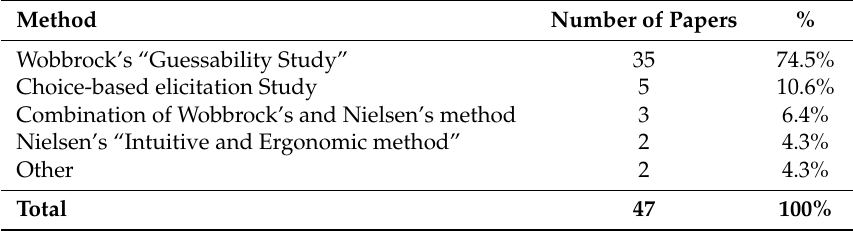
Table 4. User-based Elicitation methods employed in studies